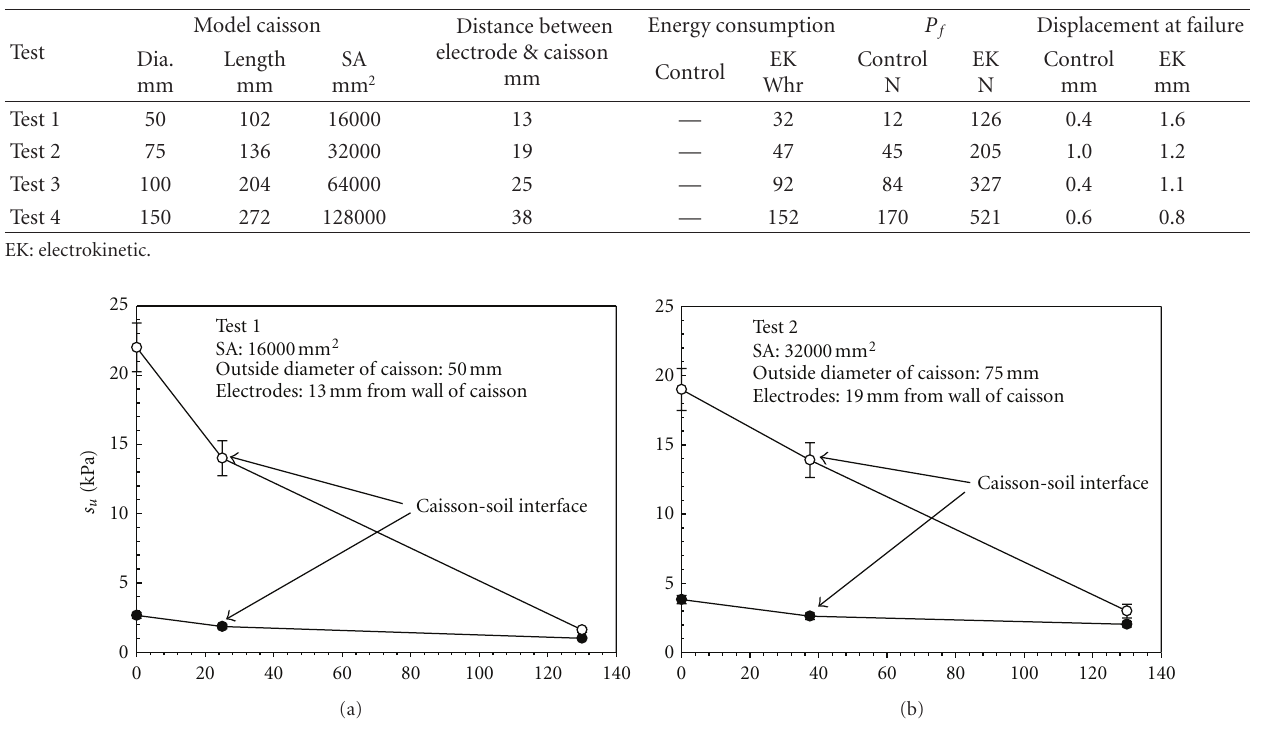
Table 1: Summary of tests and results.